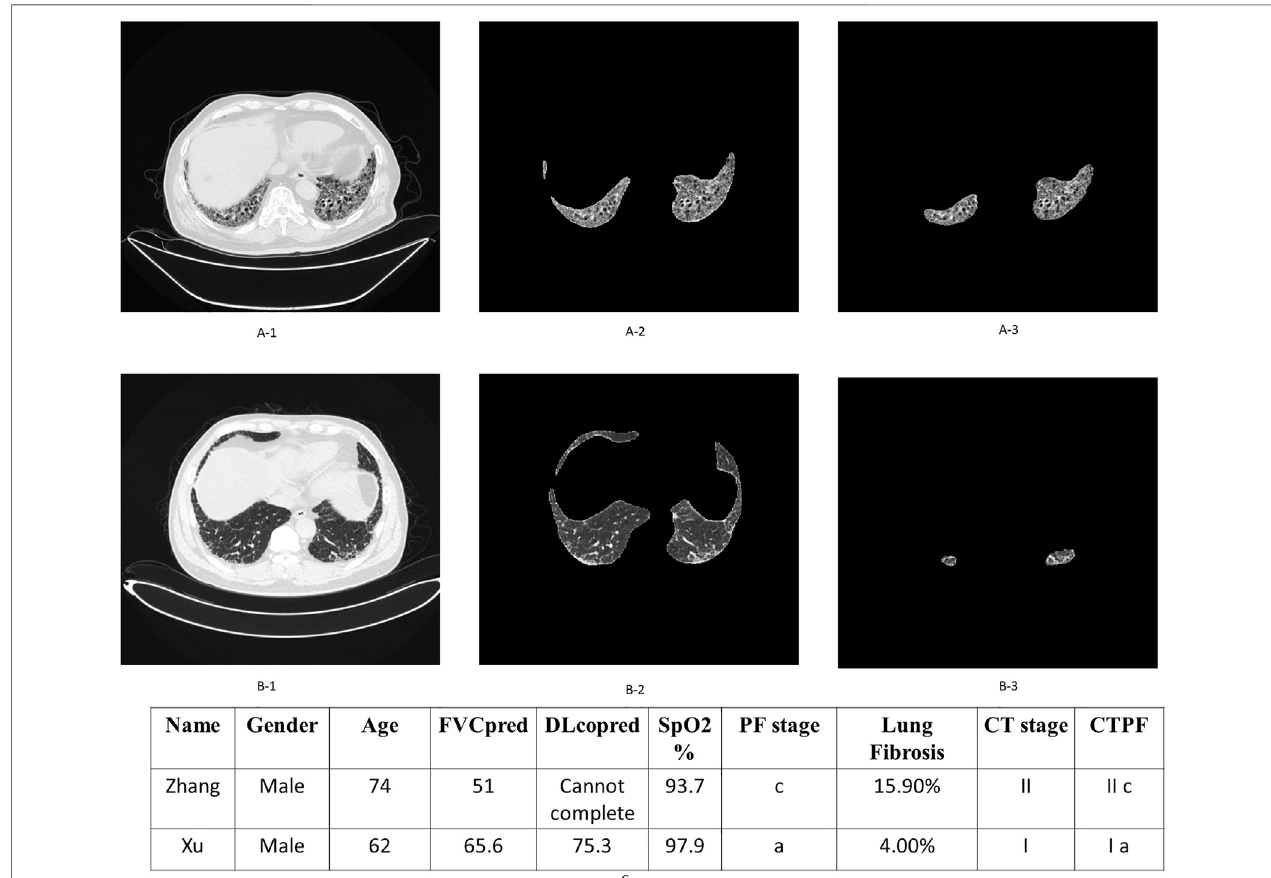
FIGURE5| Examplesofpatient ’ soriginallungCTimage, honeycomblungregionsegmentation,andstaging. (A-1,2,3) aretheoriginalCTimages, thesegmented lung region,and honeycomblungregionidenti fi edbythedeeplearningmodelofpatientZhang.ThecorrespondingstageofthispatientisIIc.Similarly, (B-1,2,3) arethe corresponding images of patient Xu, whose stage is Ia. (C) shows their comprehensive CTPF staging; patient Zhang ’ s comprehensive stage is IIc; the comprehensive stage of patient Xu is Ia.